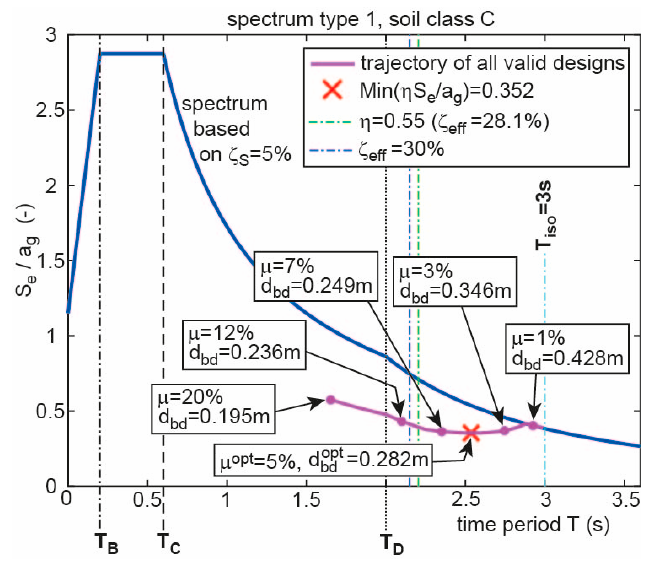
Figure 1. Elastic response spectrum including trajectory of all valid curved surface sliders (CSS) designs, limitations due to minimum reduction factor and maximum effective damping ratio and optimum CSS design for minimum structural acceleration. T : time period; T B , T C , T D : time period ranges of response spectrum; T iso : isolation time period; S e : structural peak acceleration; a g : peak ground acceleration; ζ S : structural damping ratio; ζ eff : effective damping ratio; η : reduction factor; µ : friction coefficient; µ opt : friction coefficient of optimum solution; d bd : displacement capacity; d opt : optimum displacement capacity of optimum solution.